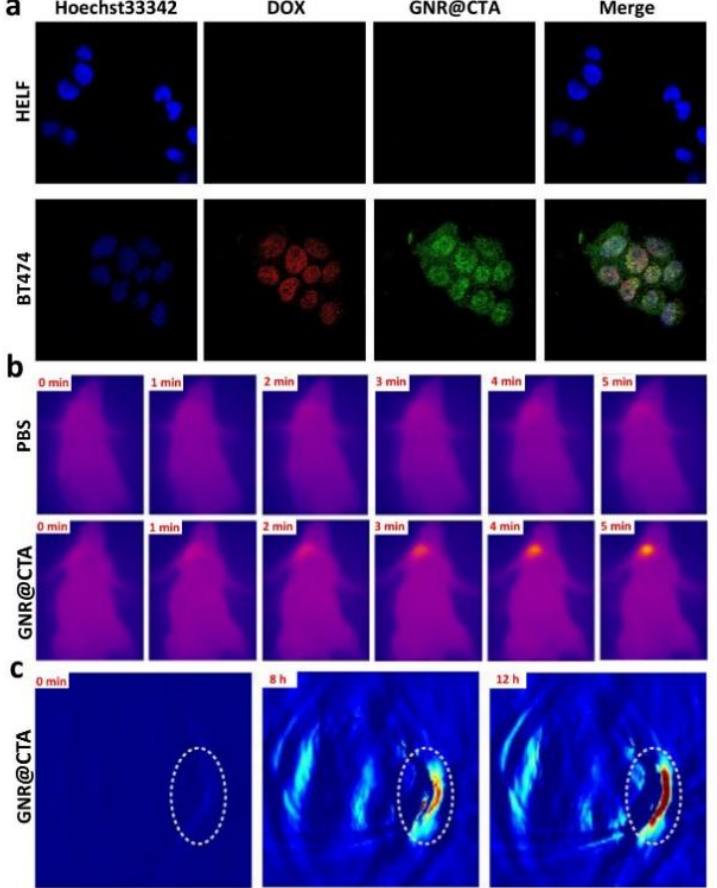
Figure 3. Intracellular drug delivery and in vivo imaging of GNR@CTA. ( a ) CLSM analysis of GNR@CTA(DOX) specific targeted drug delivery. ( b ) Infrared thermal imaging of GNR@CTA in vivo. ( c ) PAI imaging analysis of GNR@CTA in vivo.